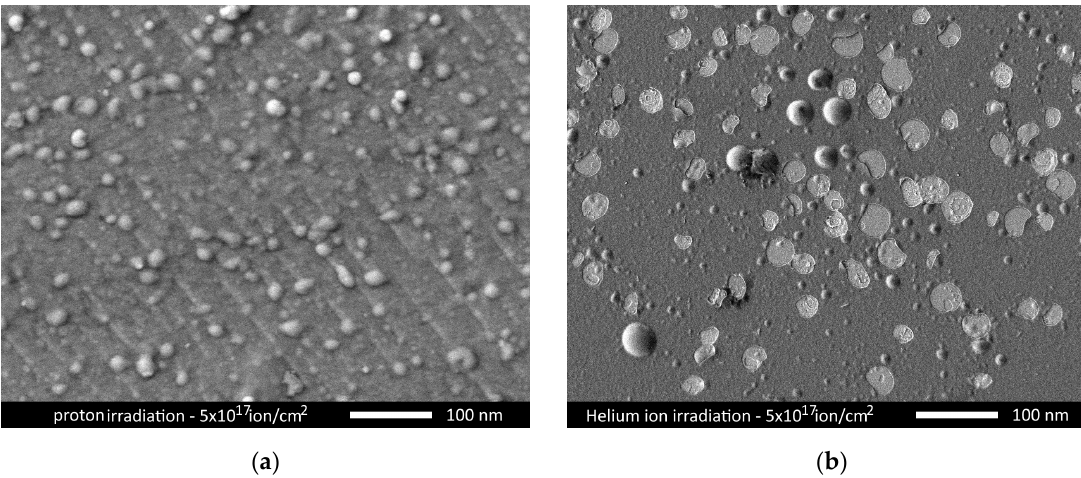
Figure 2. SEM images of morphological changes in the surface of ceramics after irradiation with a dose of 5 × 10 17 ion/cm 2 by ( a ) protons and ( b ) helium ions.